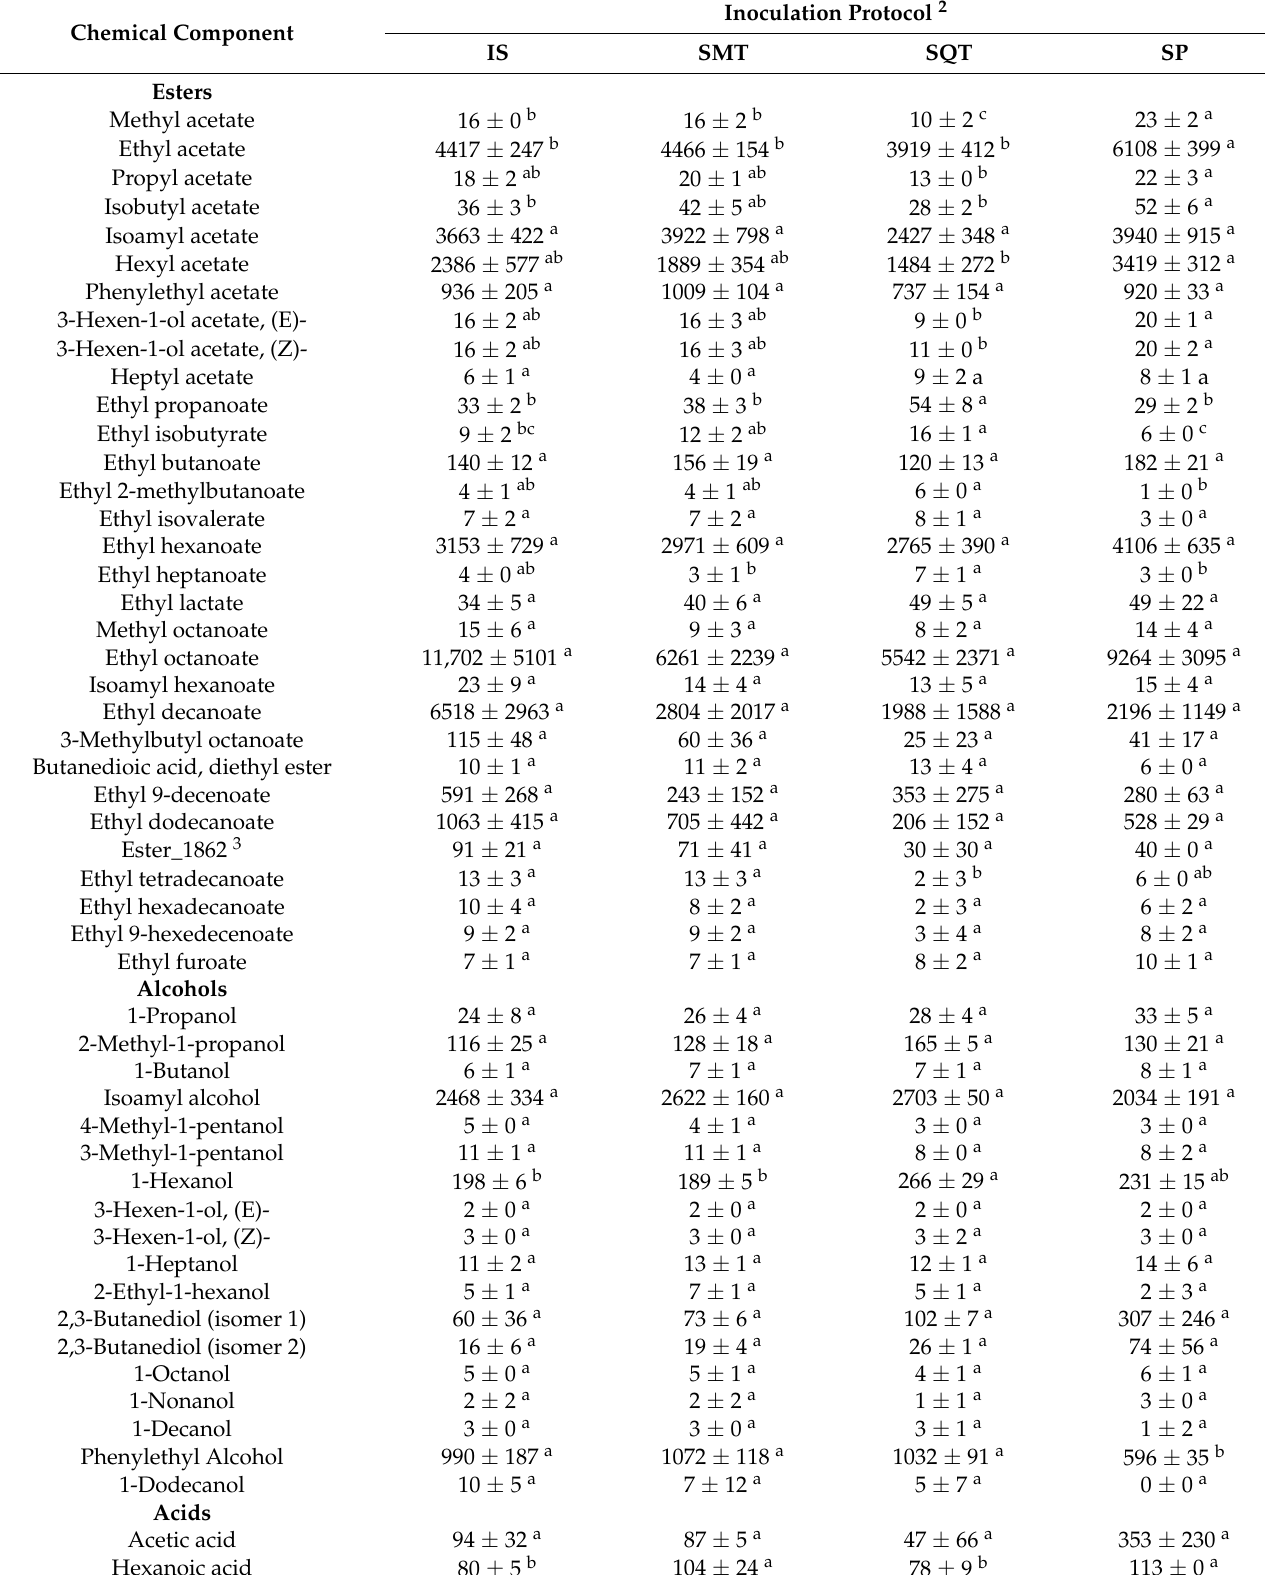
Table 7. Minor volatiles ( µ g/L) 1 of wines produced in pilot scale fermentations (mean ± SD, n = 3 or n = 2 in SP). Values not sharing a letter are significantly different ( p <